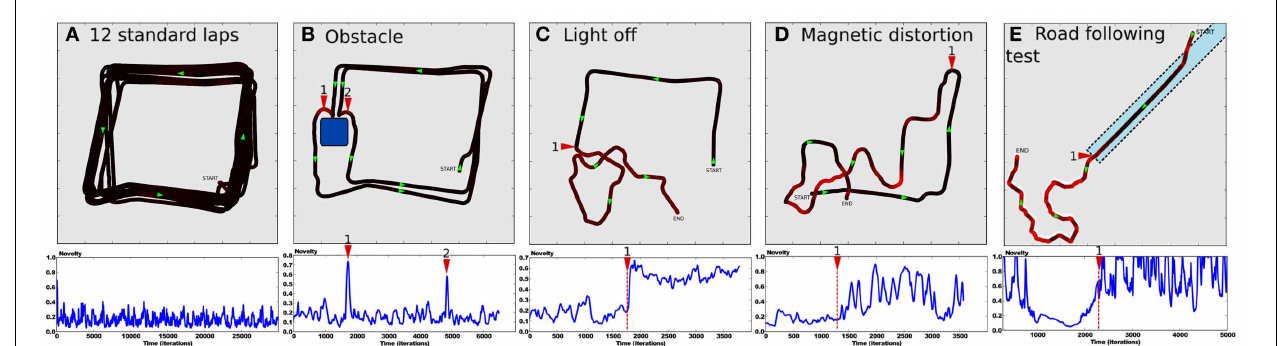
FIGURE 8 | (A–D) Results of Setup 1 (see Figure 6 ). (A) Up: trajectory after performing 12 laps autonomously without disturbance. Down:novelty level stays below 0.5 with a constant variance as no abnormal event appears. (B) Up: an obstacle suddenly appears in the environment. Obstacle detection allows the robot to avoid it. Generalization capabilities of place cells allow it to go back into the learned path. Down: novelty level shows peaks for respectively the first (1) and second (2) time the system faces the obstacle. (C) Up: the system performs its task correctly (from START to 1) when the ambient light is suddenly switched off (1). It results in random movements,